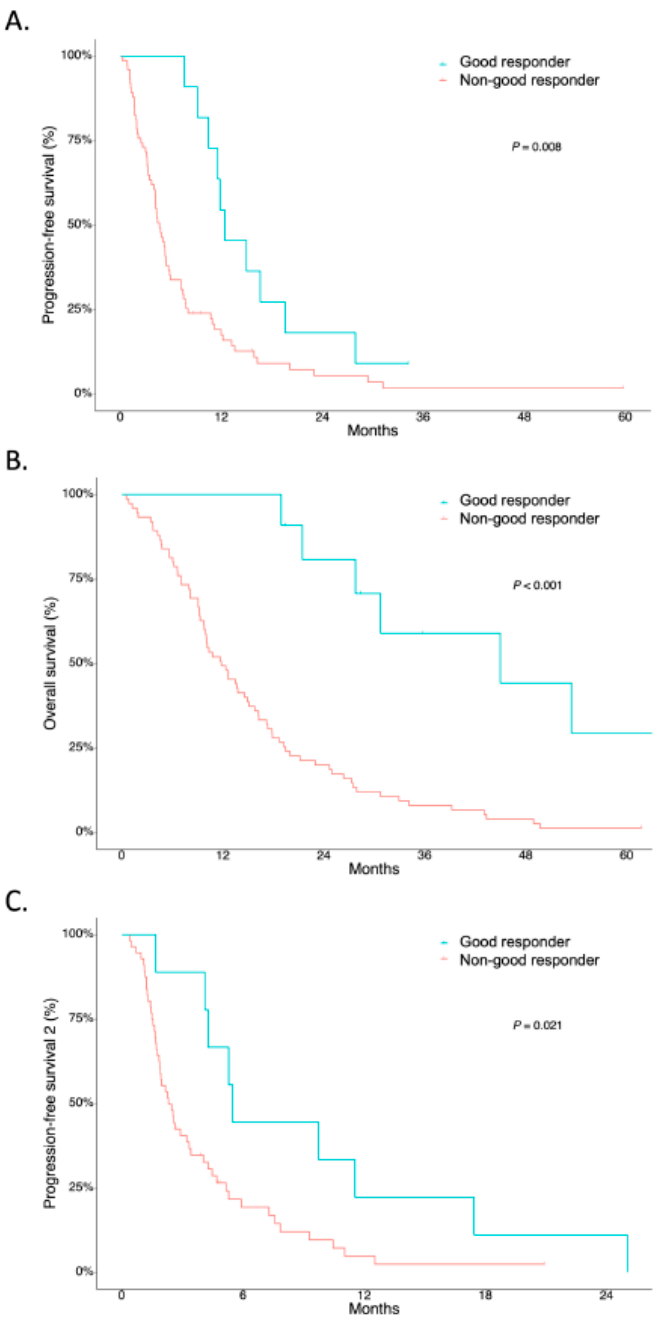
Figure 3. Survival outcomes according to patient groups: good responders and non-good responders. ( A ). PFS1, ( B ) OS, and ( C ) PFS2.